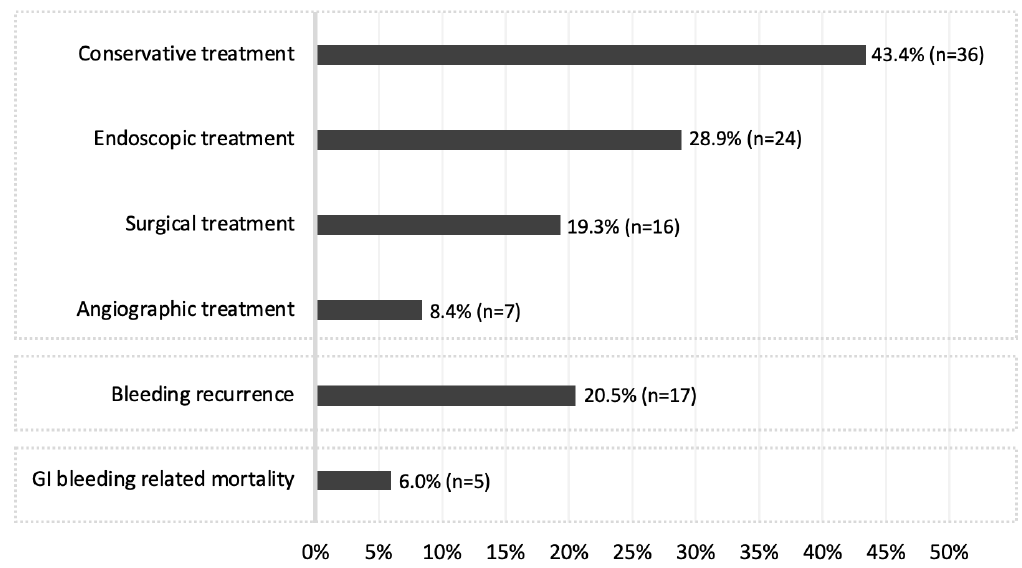
Figure 2. Outcomes after SBCE. Gastrointestinal (GI).